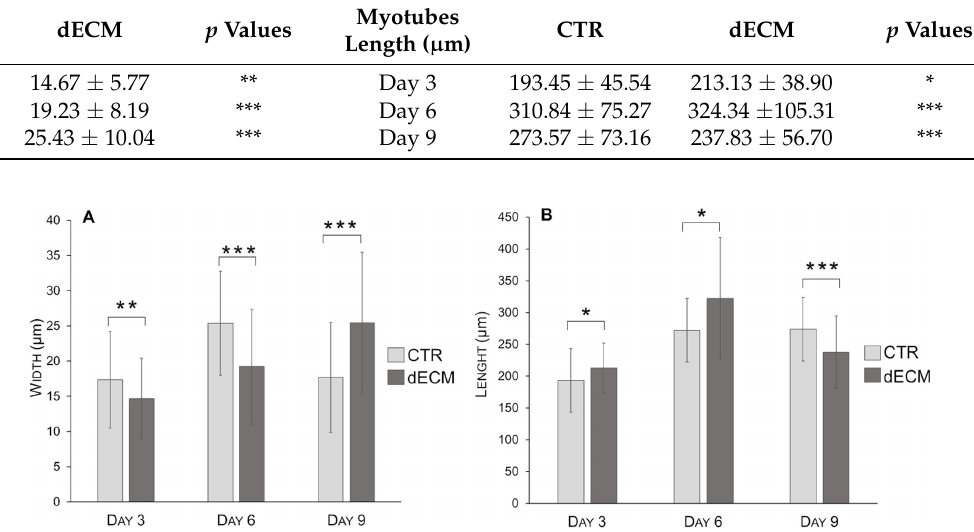
Figure 6. Morphological features of C2C12 myotubes grown on plastic plates either uncoated (CTR) or coated with dECM for different periods. Width ( A ) and length ( B ) are reported. Statistic was determined by t -test. * p < 0.05, ** p < 0.01, *** p < 0.001. A minimum of 70 myotubes were measured in each condition or time. The extent of differentiation of C2C12 cells was measured also by fusion index, which reflects multinucleated myotubes formation [31,32]. Fusion index was calculated as the average number of nuclei contained in myotubes, compared with the total number of nu- clei. Differentiation index of C2C12 myoblasts was found to be significantly increased in